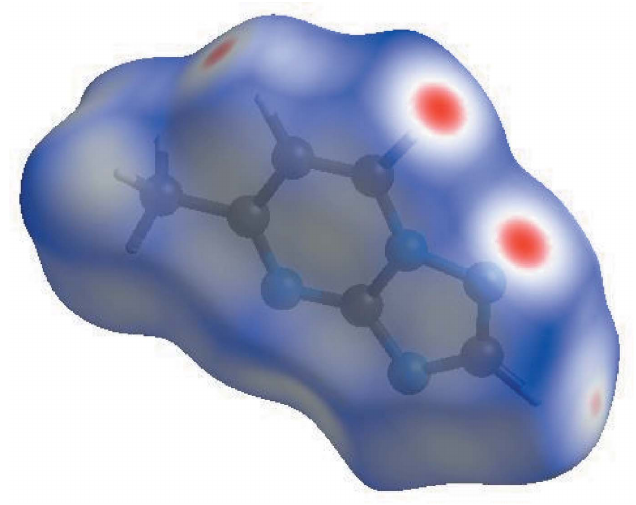
Figure 4 View of the three-dimensional Hirshfeld surface of the title compound plotted over d norm in the range (cid:5) 0.1566 to 1.0057